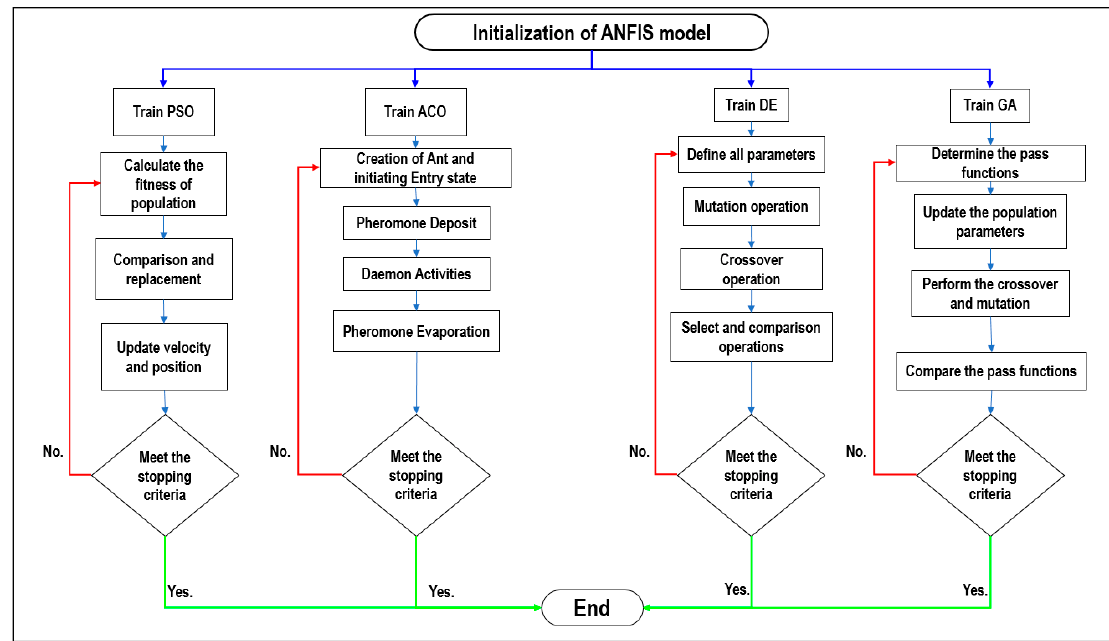
Figure 2. The flow chart of the proposed hybrid adaptive neuro-fuzzy inference system (ANFIS) model, the optimization procedure of each integrated nature-inspired algorithm.